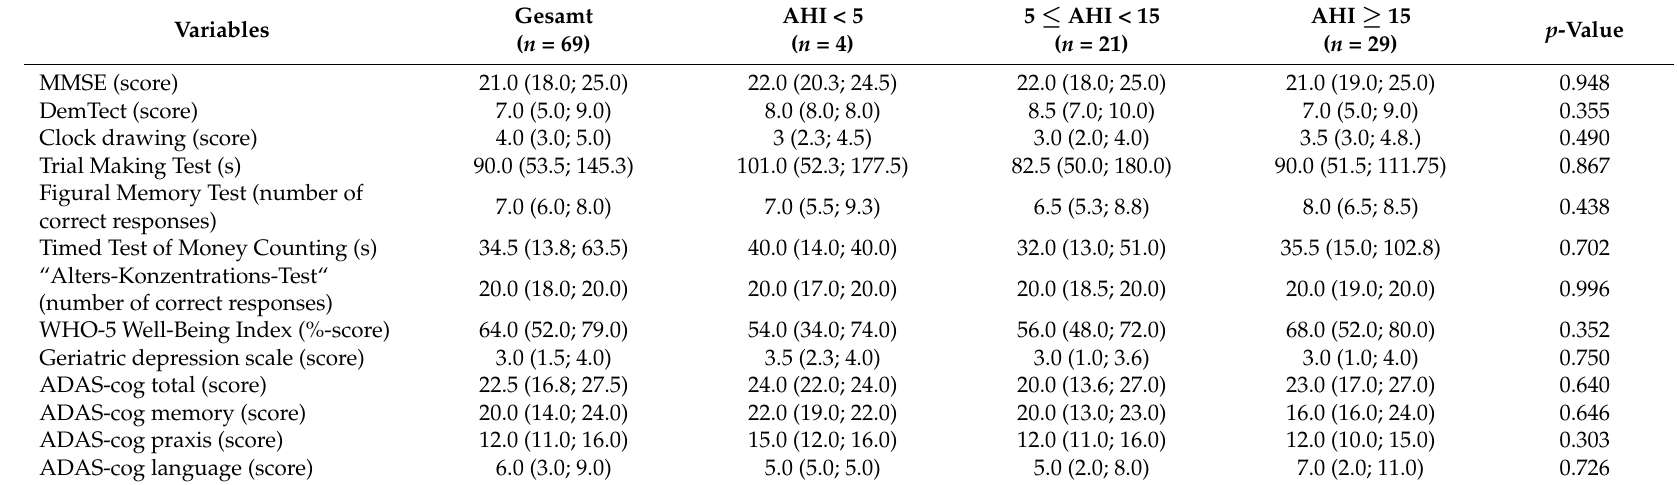
Table A4. Cognitive and emotional function also split by AHI category in non-depressed patients (geriatric depression scale score ≤ 5) *. Variables